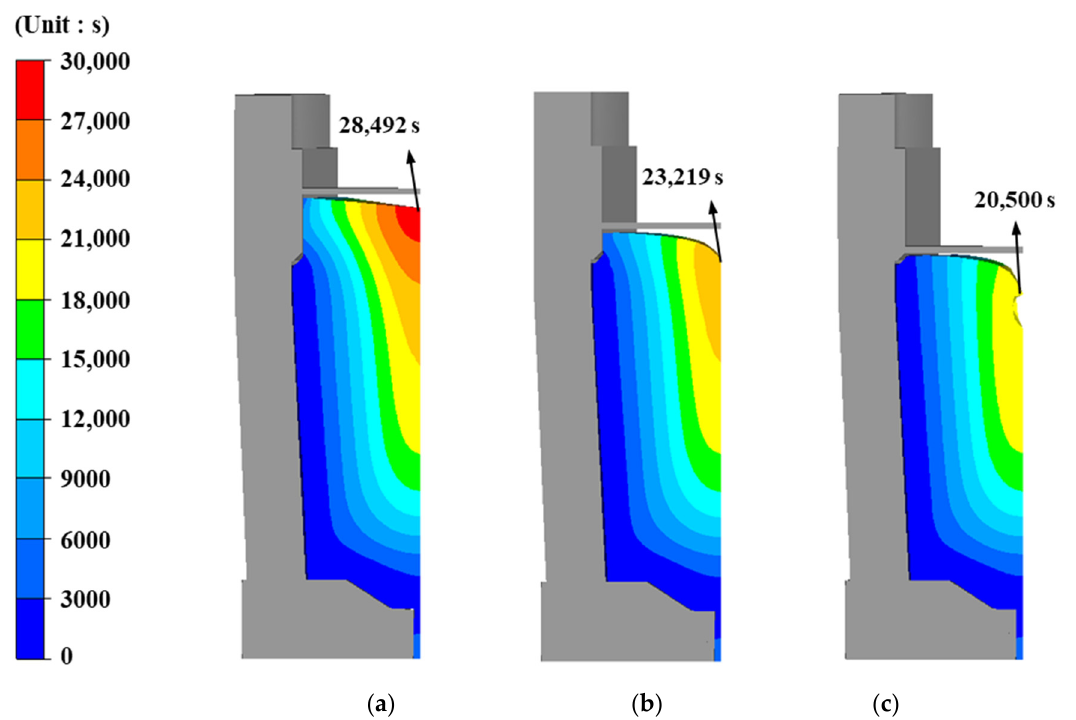
Figure 3. Total solidification time for ( a ) 16% hot top; ( b ) 8% hot top; ( c ) free hot top.